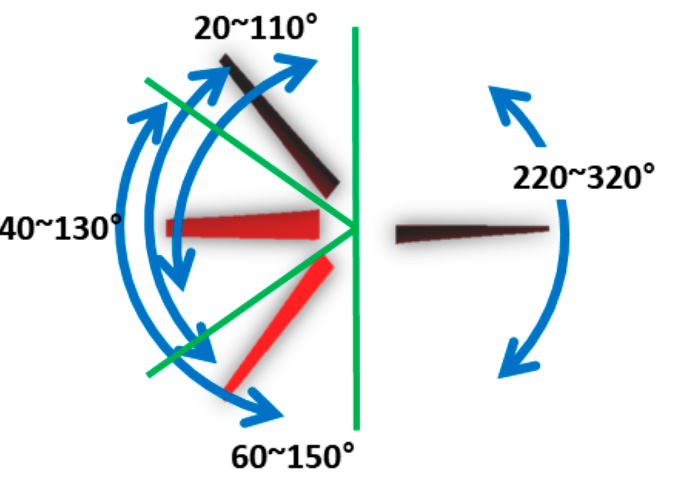
Figure 9. Blade Position Optimization Procedure.